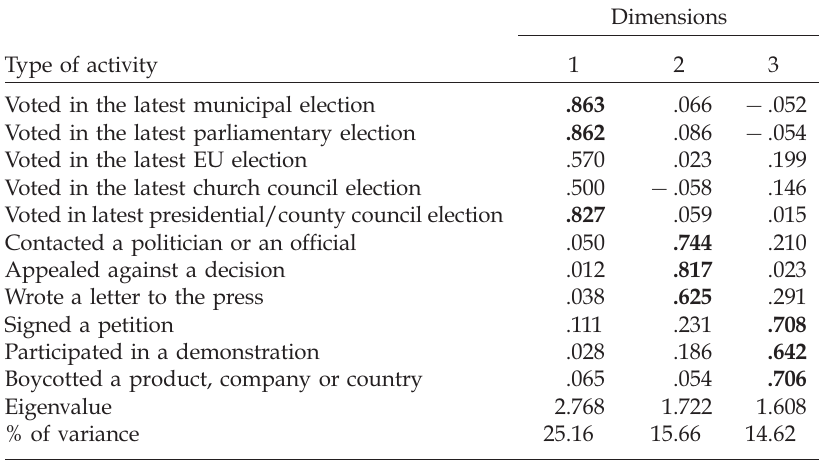
Table 3. Dimensions of political participation among older adults (N (cid:3)